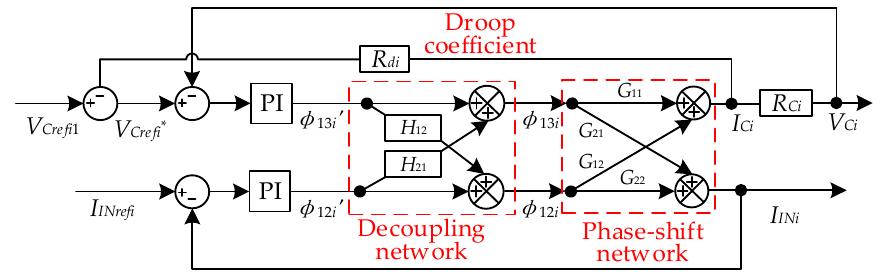
Figure 4. The control diagram of the three port converter (TPC).